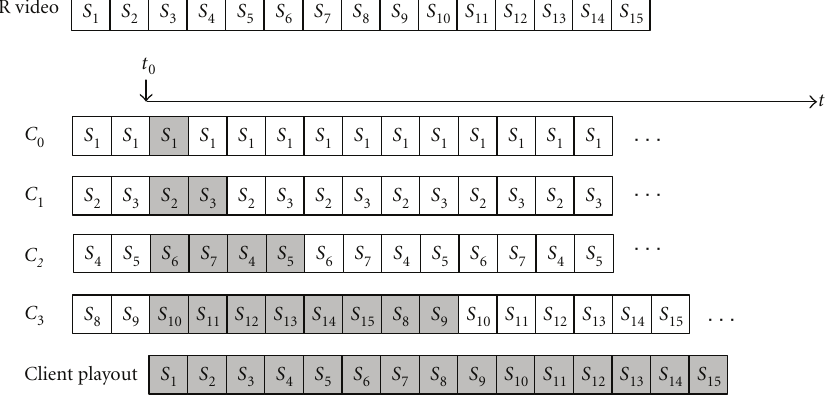
Figure 1: The FB scheme ( N = 15 and k = 3).